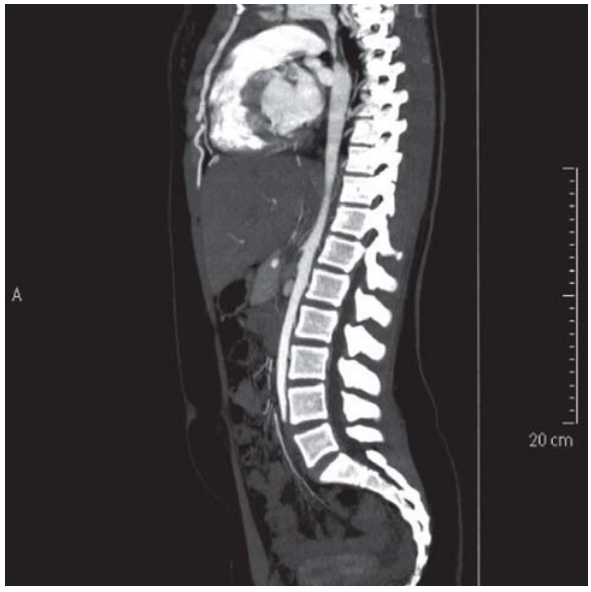
Fig. 2 / Vídeo 1 ( http://www.rbccv.org.br/video/v25n4b/) – Imagem em corte sagital demonstrando a coarctação de aorta segmentar obtido pela tomografia computadorizada de múltiplos